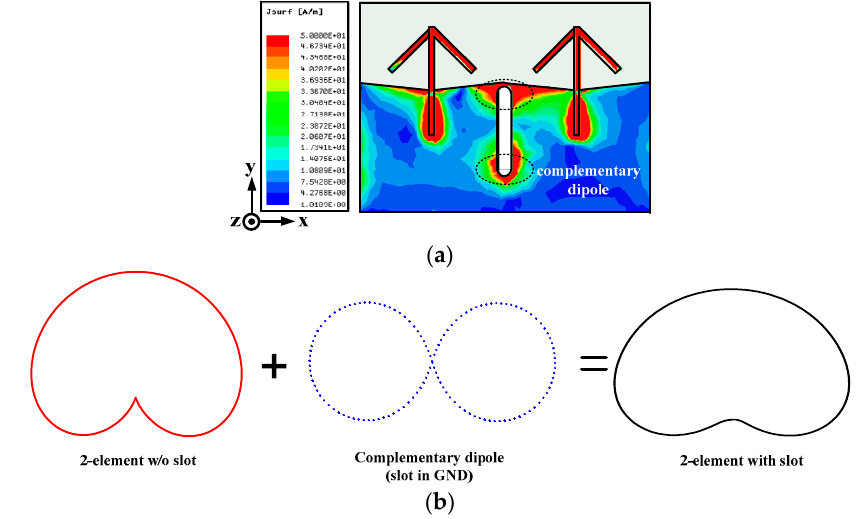
Figure 4. Implementation of the slot in the ground: ( a ) visualized mechanism of the slot as a complementary dipole source ( b ) multiplication effect of the complementary dipole source on the radiation pattern of the two-element array.